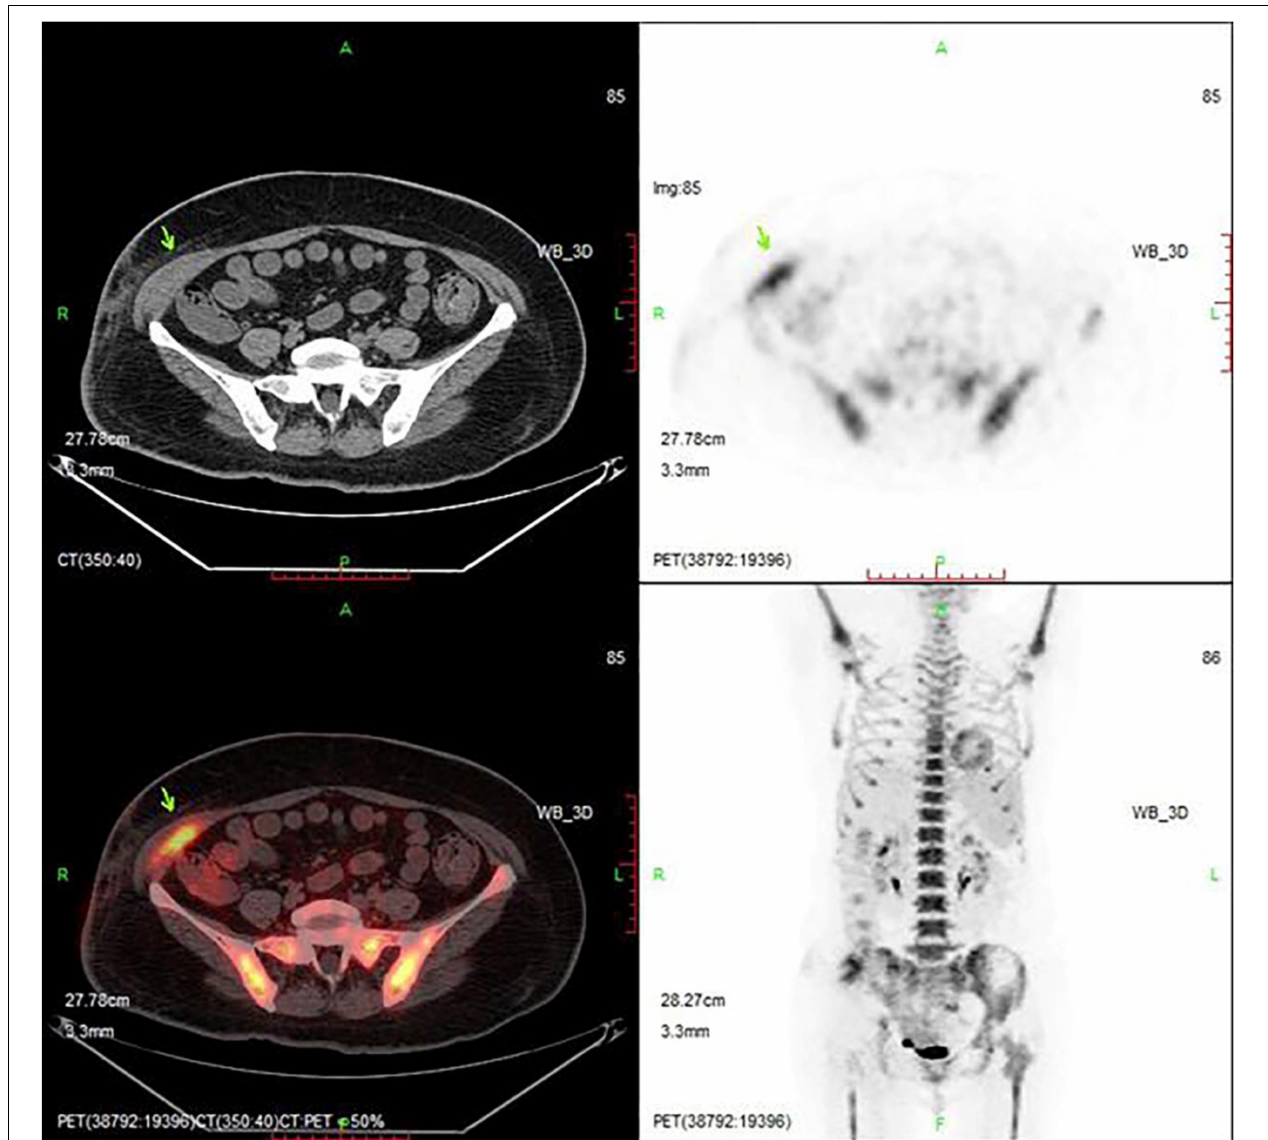
FIGURE 4 | PET/CT imaging after CAR-T cell infusion. The lesion is significantly smaller than before. The position indicated by the arrow is the location of the